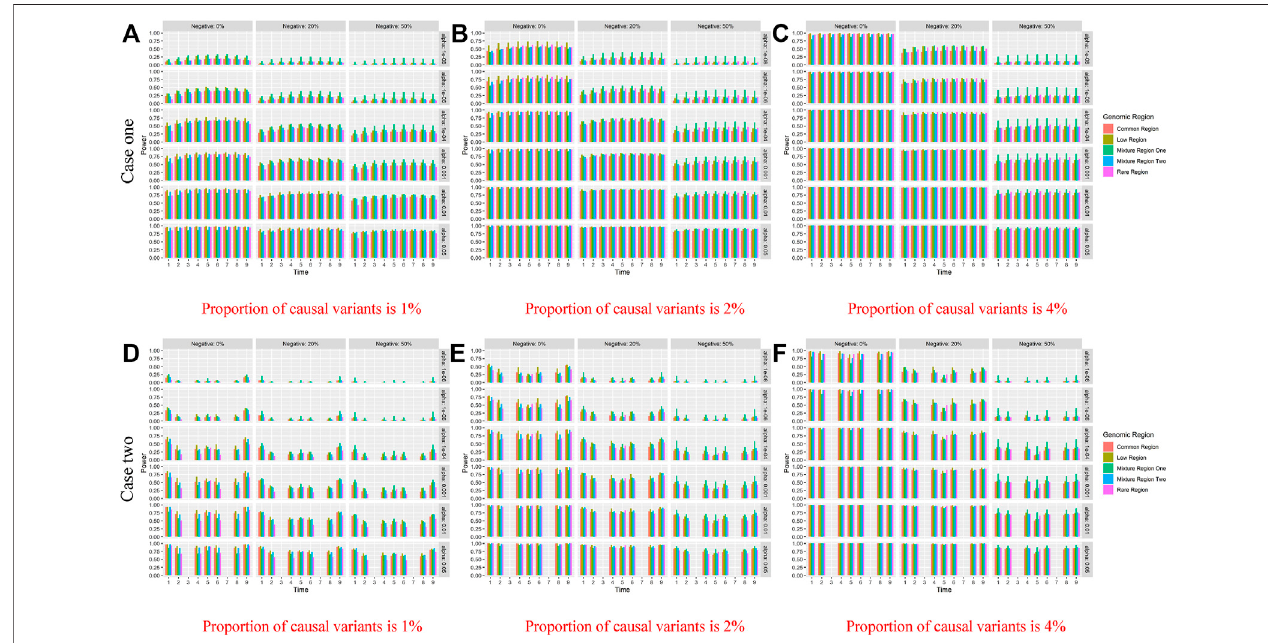
FIGURE 2 | Power of linkage equilibrium ’ s case one and case two based on LFDAT for the fi ve gene regions when c is 3, and sample size is 2000. The (A – C) denotes the power results of case one. The (D – F) denotes the power results of case two. The time effect function is θ ( t ) (cid:2) 2 + 2sin ( π t /12 ) for case one, and θ ( t ) (cid:2) 2 + 2sin ( π t /2 ) forcasetwo. (A) Proportionofcausalvariantsis1% (B) Proportionofcausalvariantsis2% (C) Proportionofcausalvariantsis4%. (D) Proportionof causalvariantsis1% (E) Proportionofcausalvariantsis2% (F) Proportionofcausalvariantsis4%.Note:Commonregiondenotesgeneregionsonlywithcommon variants, Rare region denotes gene regions only with rare variants, Low region denotes gene regions only with low-frequency variants, Mixture region one denotes gene regionswith20%ofcommonvariantsand80%ofrarevariants,andtheMixtureregiontwodenotesgeneregionswith80%ofcommonvariantsand20%ofrarevariants.